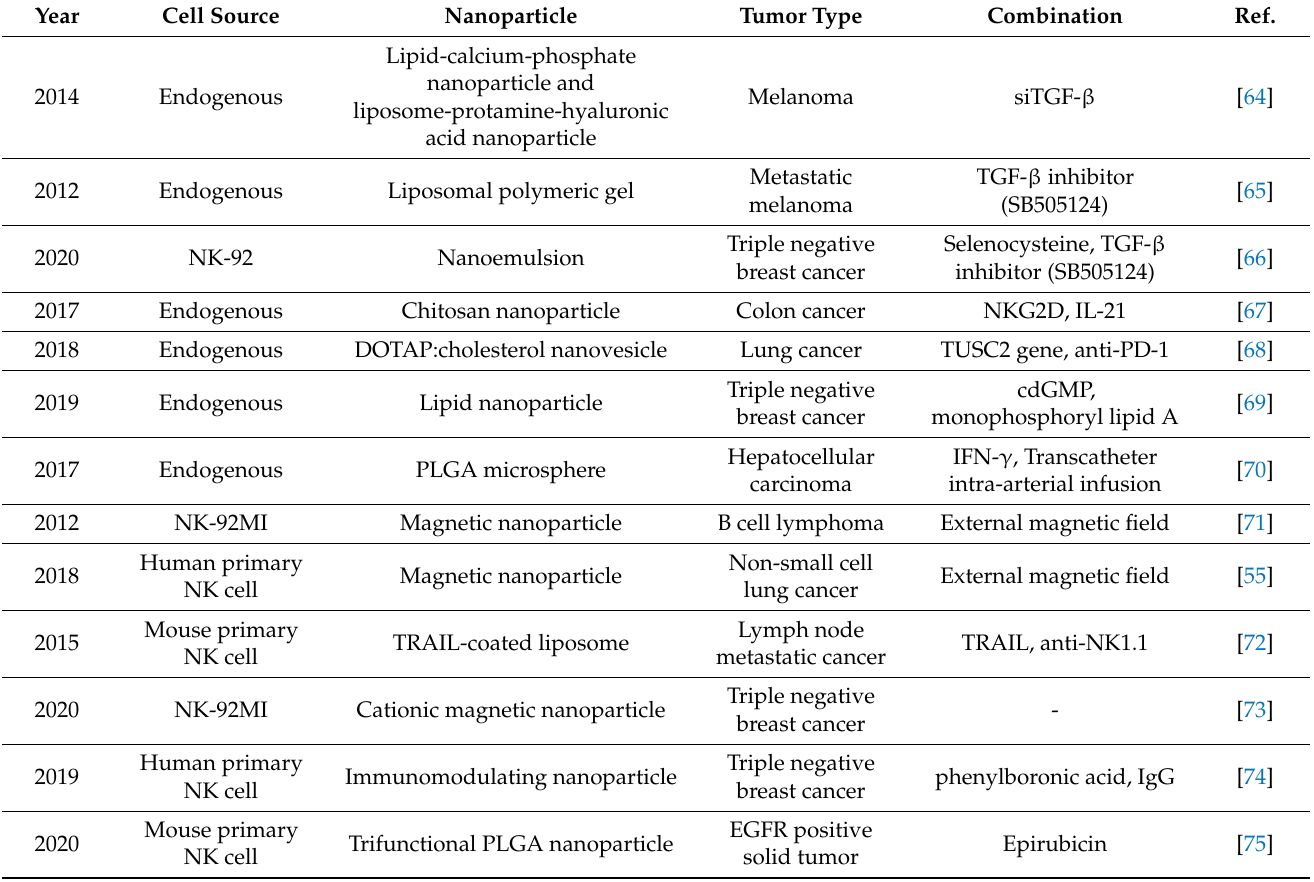
Table 2. Preclinical strategy of nanoparticle-based NK cell